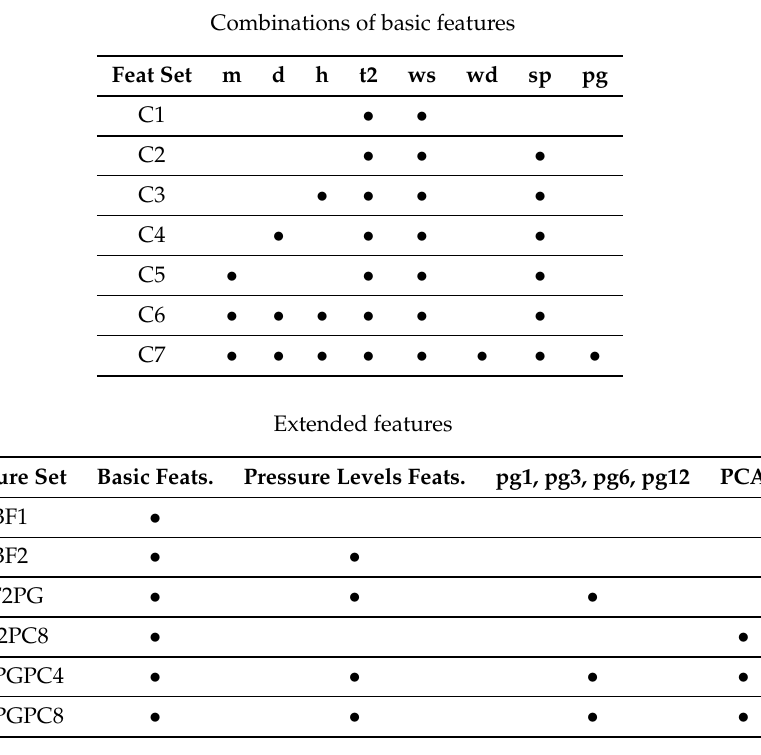
Table 1. Defining feature sets in Prediction Intervals (PI)